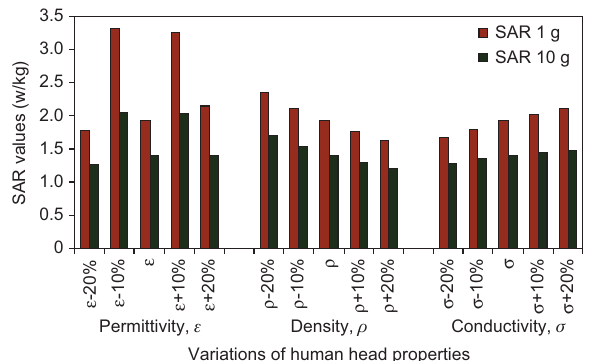
Figure 3 SAR values in human head at 900 MHz with antenna substrate of